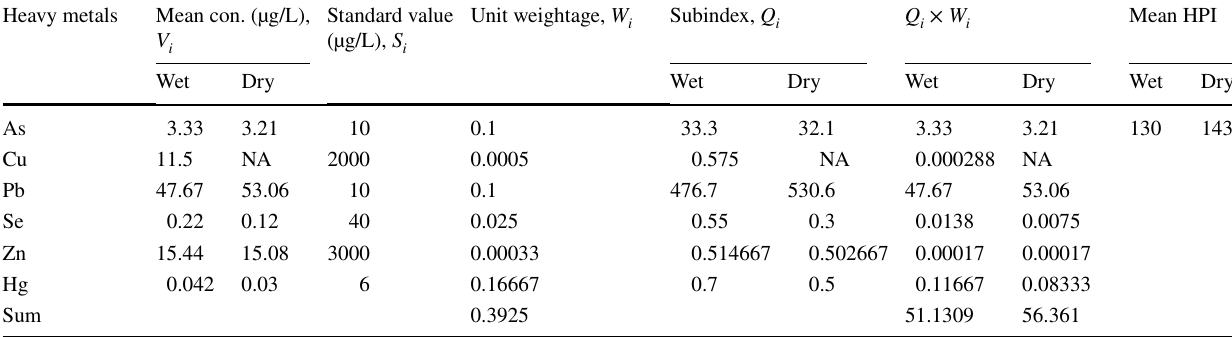
Table 3 Heavy metals pollution index (HPI) of water sample in the water supply system Heavy